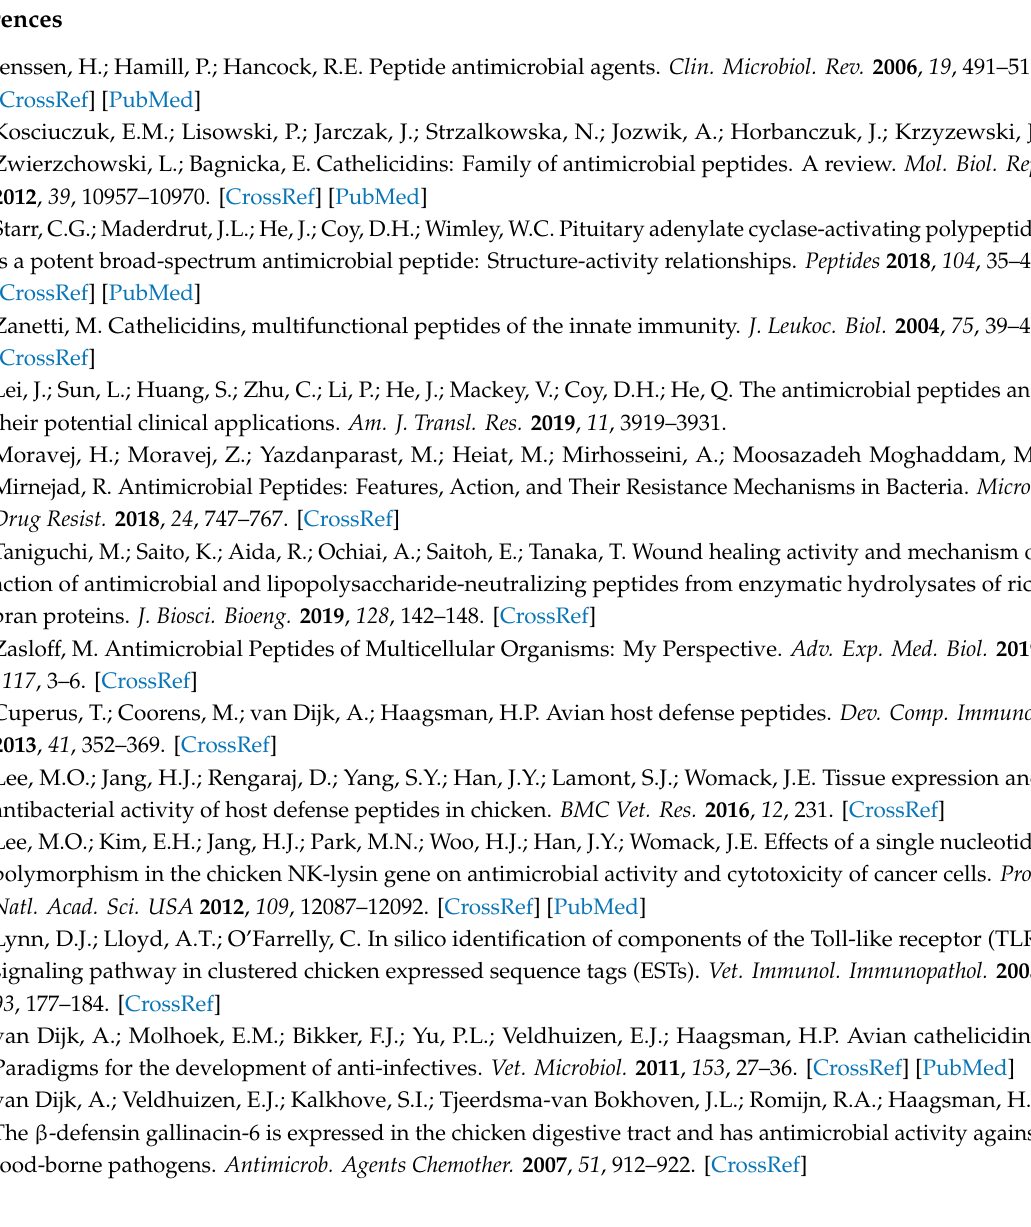
Figure S1: PCA analysis before and after raw Ct imputation; Figure S2: Statistical analysis of dCt values of host defense peptide (HDP) genes among experimental